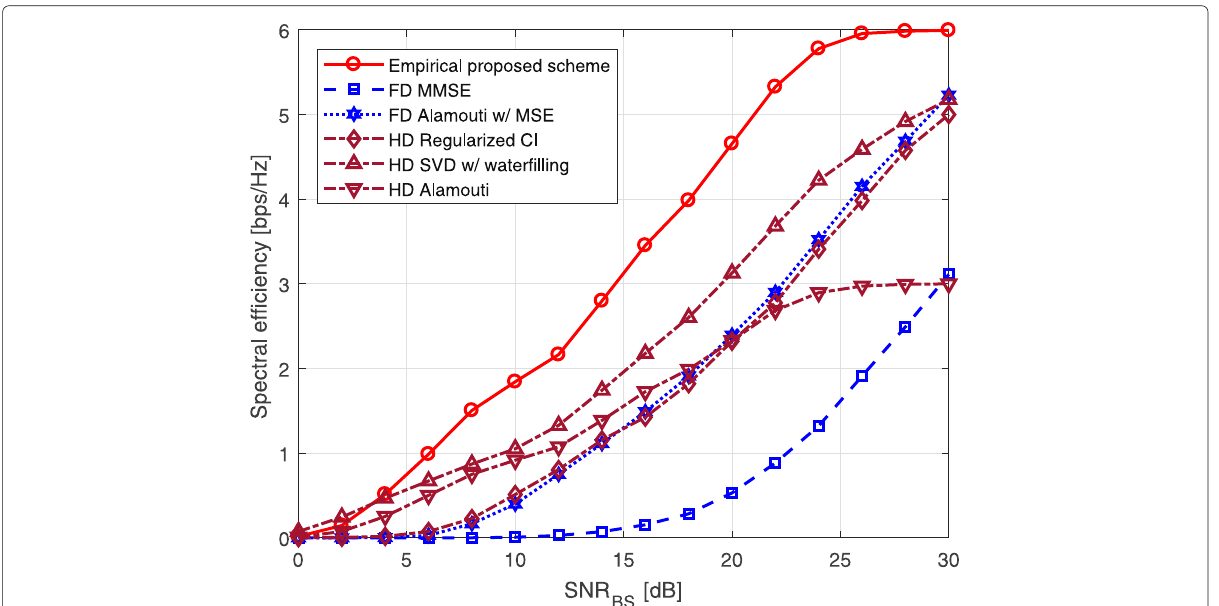
Fig. 3 The DL spectral efficiencies of the proposed scheme and the existing schemes according to BS transmission